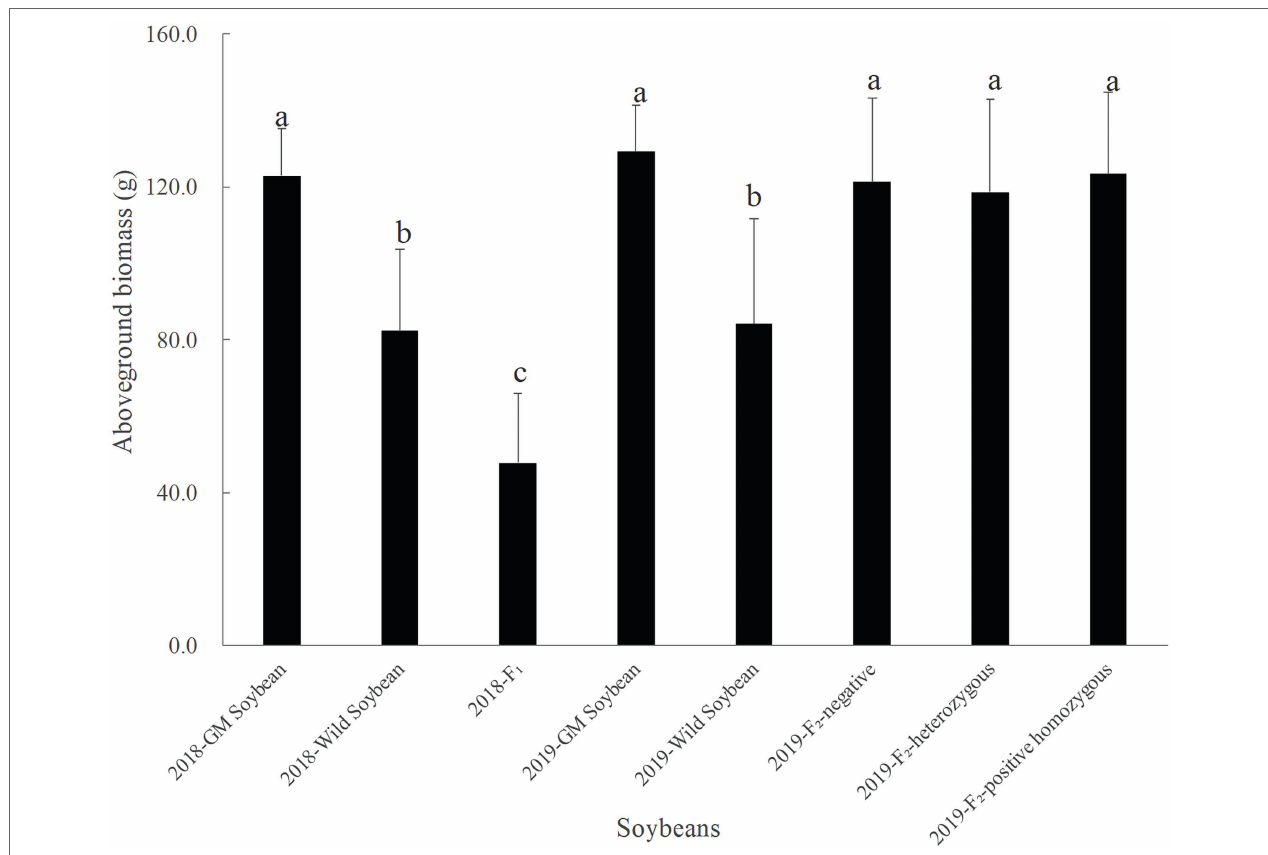
FIGURE 3 | Aboveground biomass of transgenic, wild soybeans, and hybrid progeny